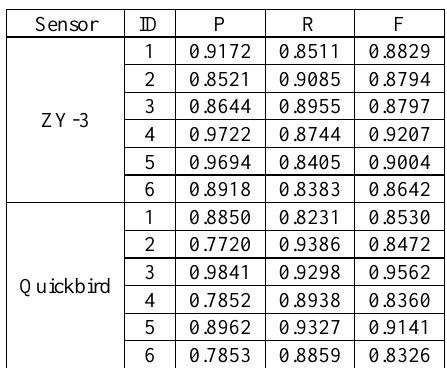
Figure 1. The change of F -measure with s for ZY-3-1 image